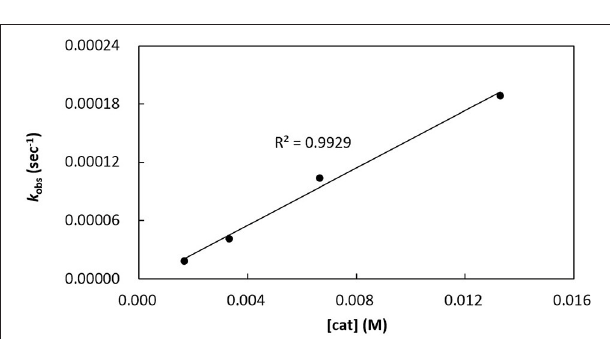
FIGURE 8 | Plot of k obs vs. concentrations of [ 3a ]Al(OCH 2 Ph) for ROP of rac -LA in toluene- d 8 at 70 ◦ C; [ rac -LA] 0 =